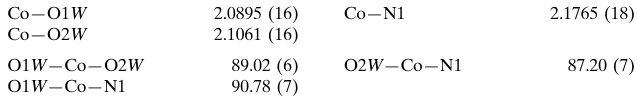
Selected geometric parameters (A˚ , (cid:2) ).